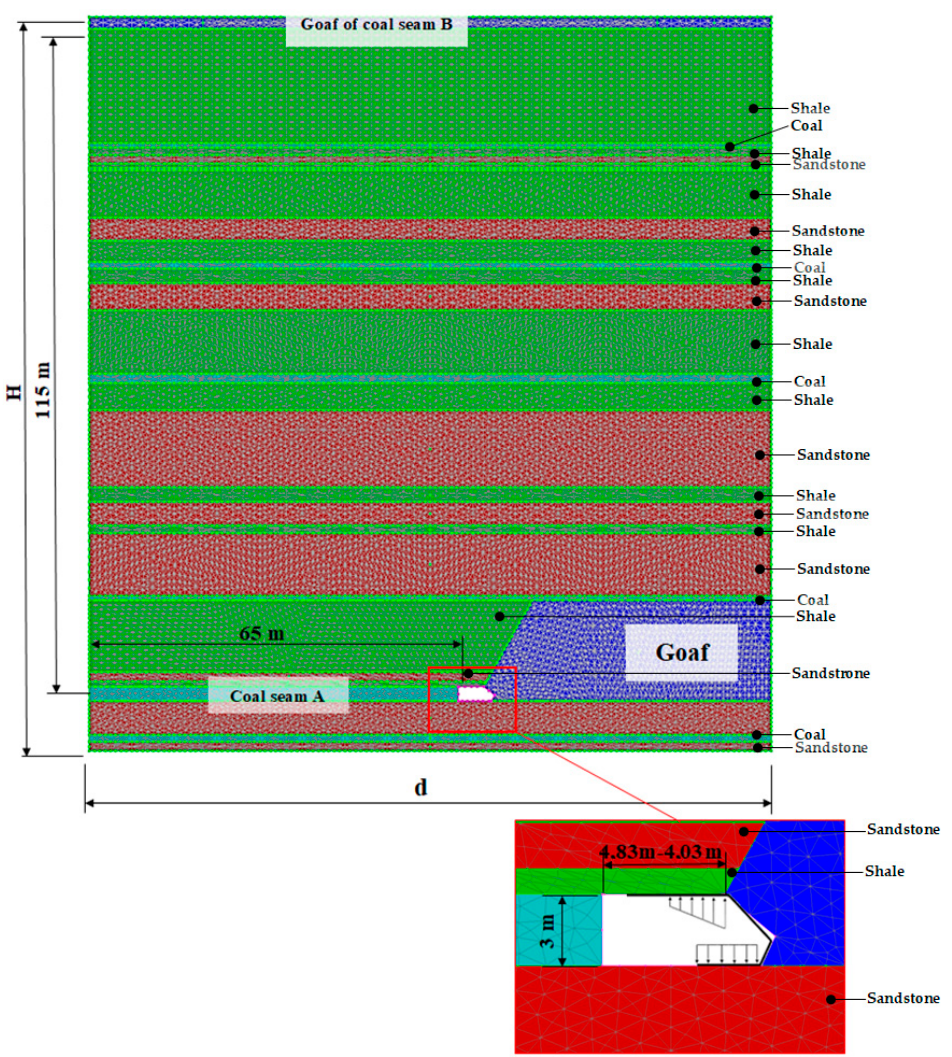
Figure 5. Numerical grid of the cross-section of the analyzed rock mass for variant II.